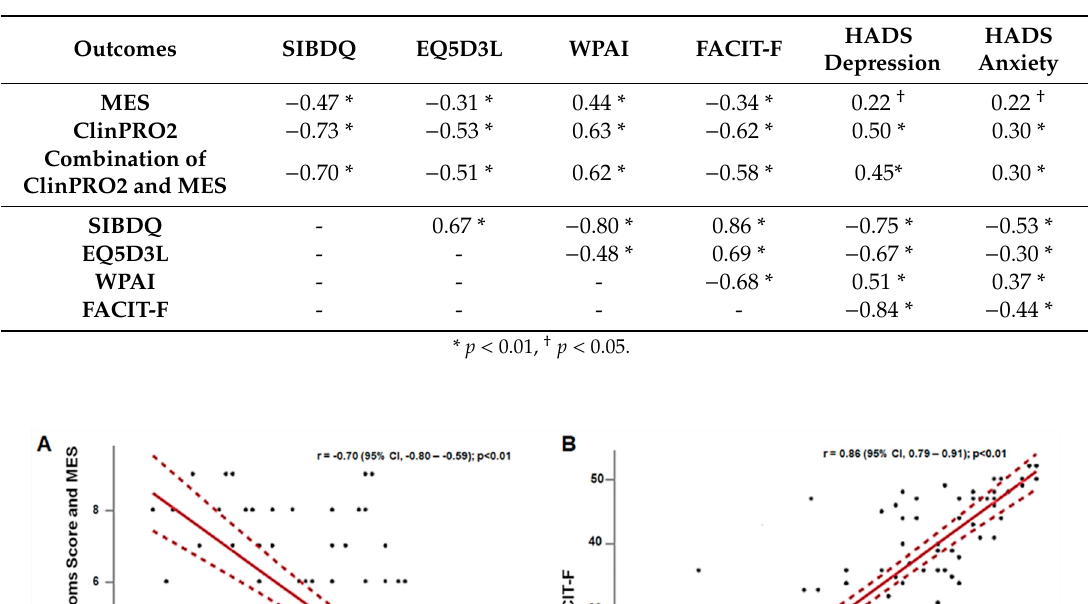
Table 2. Spearman’s correlation between ClinPRO2, Mayo endoscopic subscore, and patient-reported outcomes (PROs).